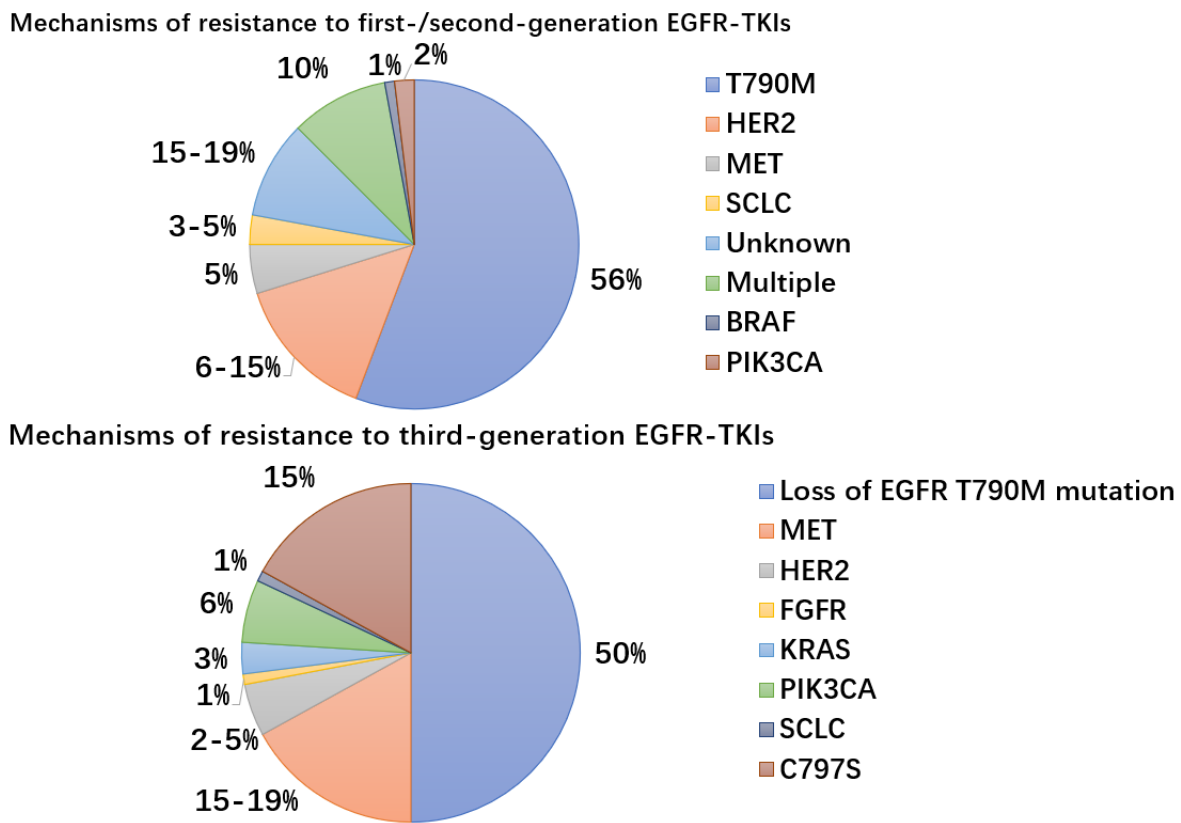
Figure 2. Mechanisms and frequency of resistance to EGFR-TKIs. MET gene amplification, PIK3CA gene mutations, bypass pathway activation, downstream pathway activation, EGFR modification